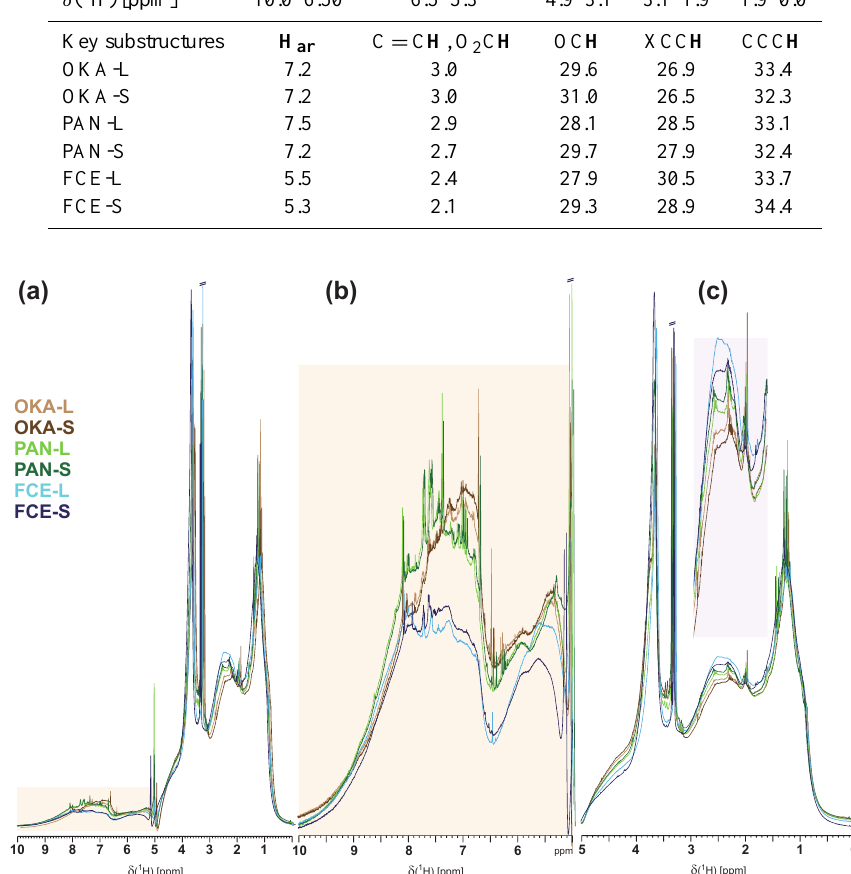
Figure 2. 1 H NMR spectra of six wetland SPE-DOM (500MHz; CD 3 OD); overlay: intensities are normalized to total NMR resonance area in the entire chemical shift range shown ( δ H = 0–10ppm), with exclusion of residual water and methanol NMR resonances (Fig. S1). (a) Entire NMR spectrum ( δ H = 0–10ppm), with section of unsaturated protons ( δ H = 5–10ppm), highlighted in orange; (b) section of unsat- urated protons ( δ H = 5–10ppm); (c) section of aliphatic protons ( δ H = 0–5ppm); highlighted in purple: vertical expansion of